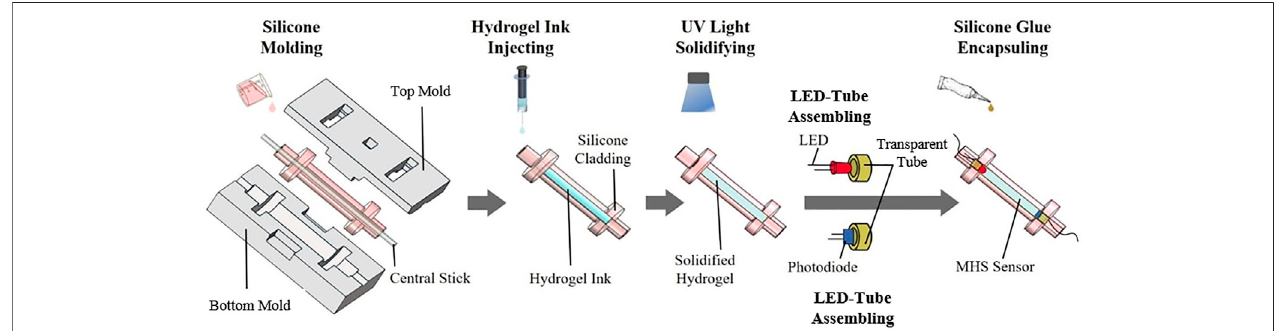
FIGURE 4 | Procedures for fabricating the MHS